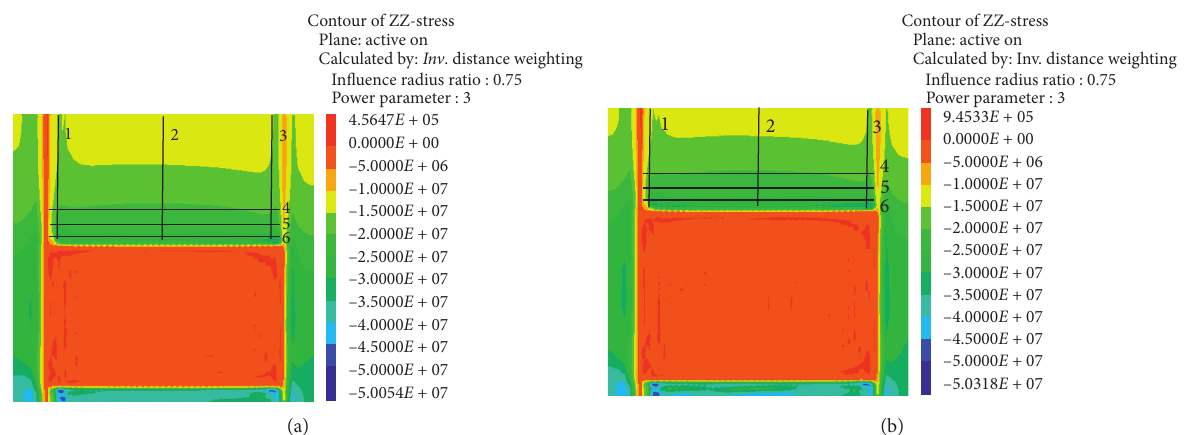
Figure 6: Stress distribution of two working conditions. (a) Presplitting blasting the roof strata. (b) Non-presplitting blasting the roof strata.